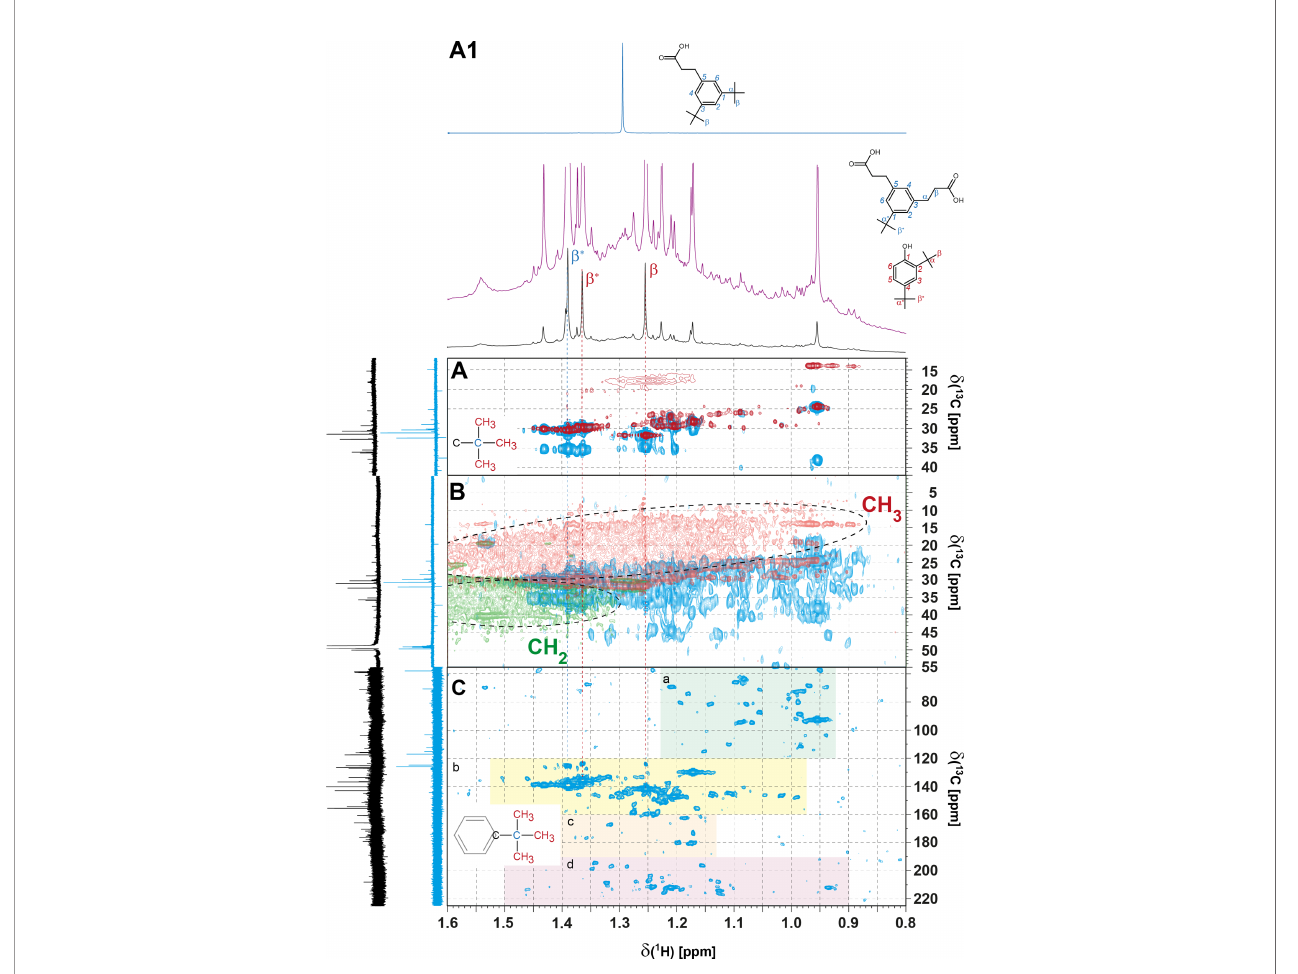
FIGURE 4 | 1 H NMR detected NMR spectra of CCCH 3 groups of L05_1000m SPE-DOM; (A) : most intense NMR cross peaks indicative of tert-butyl containing abundant molecules, with cross peaks from 1 H, 13 C DEPT-HSQC NMR spectra in red and those of 1 H, 13 C HMBC in blue color; (B) : 1 H, 13 C DEPT-HSQC (red: CH 3 ; green CH 2 ) and 1 H, 13 C HMBC (blue) NMR spectra of L05_1000m SPE-DOM, shown down to lower cross peak amplitude; the common, contiguous cross peaks of biogeochemical organic matter show up in this display labelled by ellipsoids (cf. Figures S15, S16 );. 1 H, 13 C HMBC cross peaks (blue color) represent common aliphatic branching mo fi s of DOM and relatively abundant molecules with considerable extent of aliphatic branching as exempli fi ed by d C ranging down to d C ~55 ppm (CCCH units). (C) : 1 H, 13 C HMBC cross peaks (blue color) demonstrating abundance of aromatic compounds ( C ar H and C ar O units; d C ~ 120-160 ppm), a few carboxylic acids ( d C ~ 165-185 ppm), and several ketones ( d C ~ 195-220 ppm). Some of these units could represent to benzylic units of general character C 6 H x Z-C a (CH 3 ) n -Y 3-n in which Z would represent aromatic substitution and Y oxygenated aliphatic and aromatic units, including carboxylic acids and ketones. The benzylic position C a would not carry directly bound protons, and tert. butyl C 4 H 9 then represents the most basic unit of such benzylic position. 13 C NMR spectra are 13 C single pulse (black) and CH 2 - selective (blue) 13 C DEPT NMR